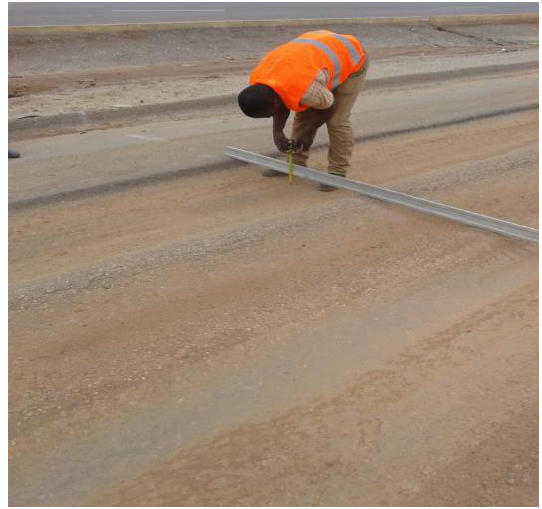
Figure 8. Profile measurements (Chibuluma).